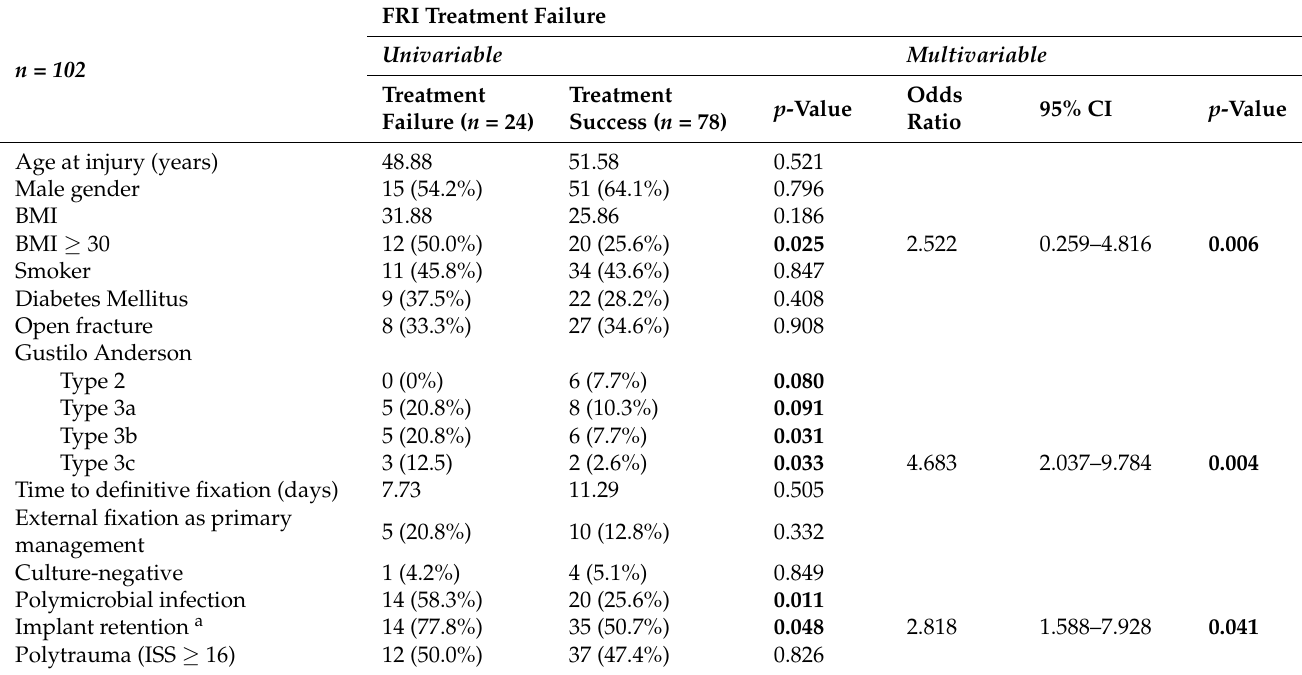
Table 6. Univariable and multivariable logistic regression